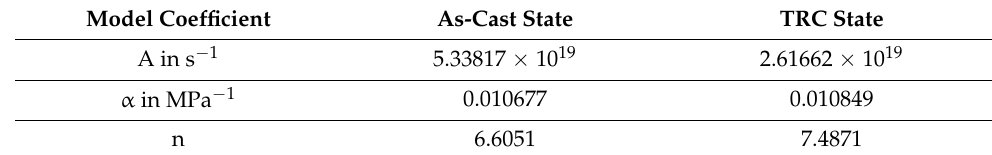
Table 3. Model coefficients for determination of Z according to Equation (1).